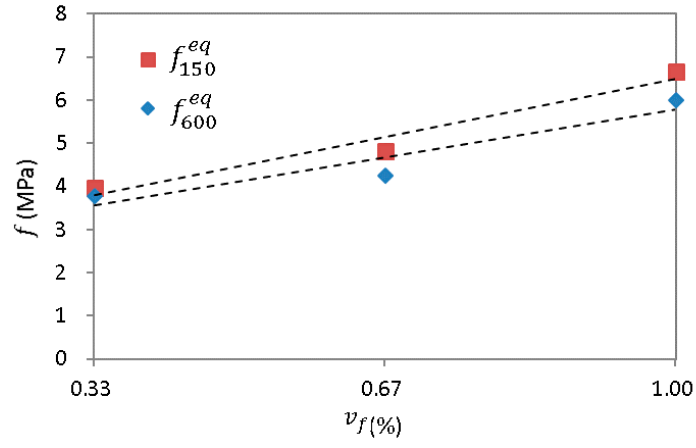
Figure 4. Residual strengths 𝑓 (cid:2874)(cid:2868)(cid:2868)(cid:3032)(cid:3044) and 𝑓 (cid:2869)(cid:2873)(cid:2868)(cid:3032)(cid:3044) with increasing fiber volume percentages from 0.33 to 1.00%.